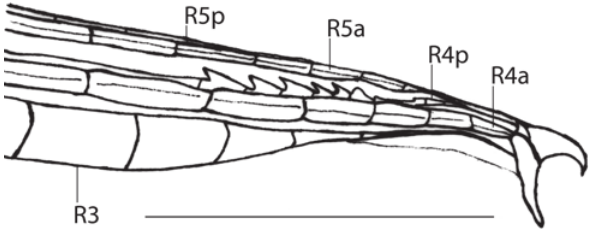
Fig. 41. Gonopodium tip of Phalloceros uai , MCP 30511. R3, R4a, R4p, R5a, R5p indicate gonopodial rays. Scale bar 1